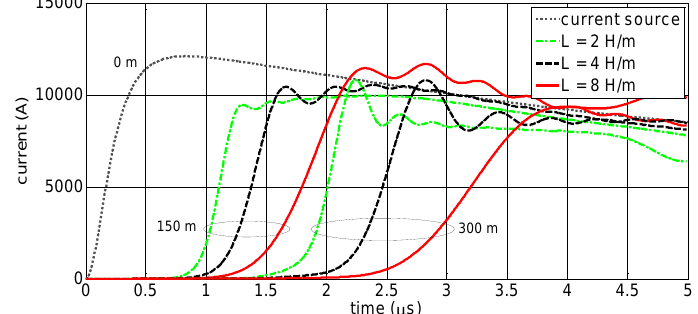
Figure 9. Current distribution along the lightning channel at different heights calculated by CST-MWS for L = 4 μH/m and R = 1 Ω/m for channel length = 0–500 m, R = 6 Ω/m for channel length = 500–2000 m. Model C : Wire in free-space loaded by distributed series inductance. Ellipses in the plot are used to link together the curves corresponding to each height along the channel.